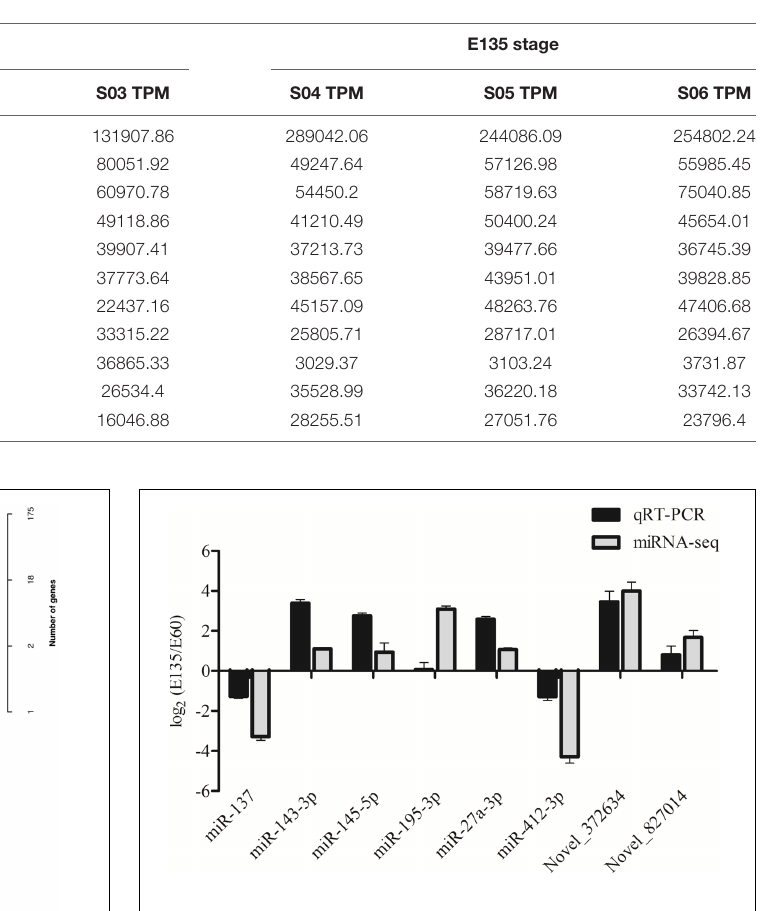
FIGURE 4 | Validation of differentially expressed miRNAs by stem-loop